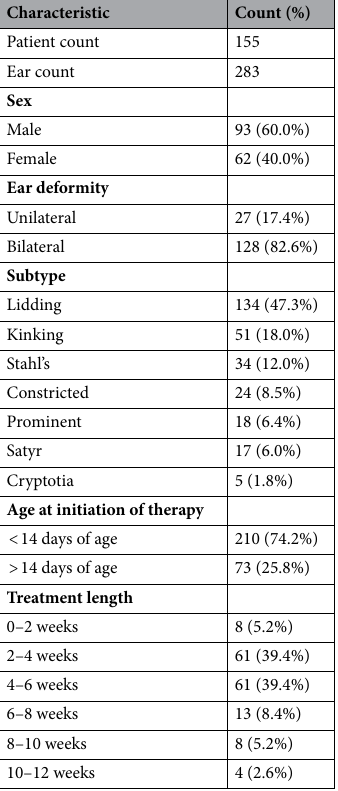
Table 1. Patient demographics and deformity